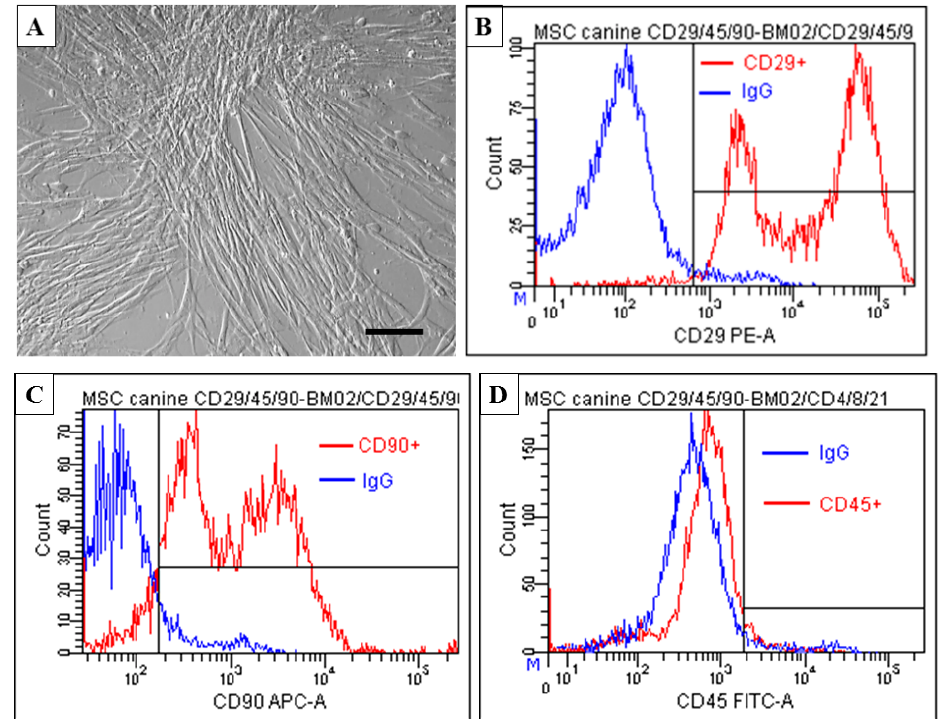
Figure 1. Immunophenotyping of bone marrow tissue-derived MSC (BMMSC) at passage 3. ( A ) Note confluent population of BMMSC revealing spindle-shaped morphology. ( B – D ) Flow cytometry analyses of BMMSC expressing high percentage of mesenchymal markers CD29 + (88.5 ± 2.2%) and CD 90 + (77.3 ± 4.6%) and low percentage of hematopoietic markers CD 45 + (3.0 ± 1.7%). Scale bar A = 50 μ m.